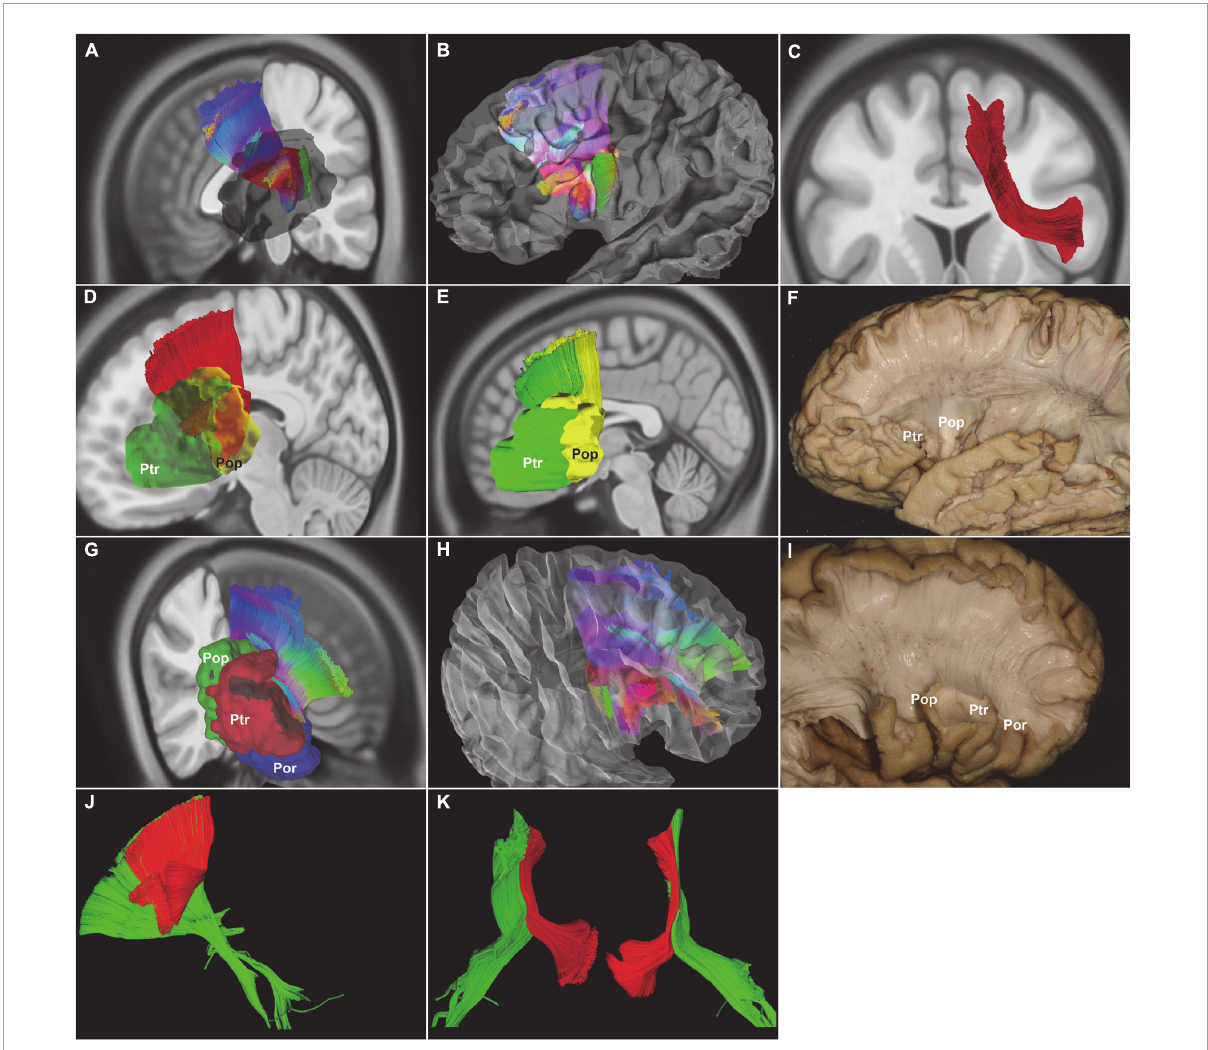
FIGURE4 In vivo fiber tractography of the FAT (HCP-842). (A–C,F) The left FAT arose from the Broca’s region and projected to the SMA, MSFG, and LSFG. (D,E) Further analysis of the fiber contribution between the Ptr (green) and Pop (red). (G–I) The right FAT covered almost the entire length of the IFG. (J,K) The FAT fibers (red) were a very thin layer above the internal and external capsule fibers (green). FAT, frontal aslant tract; IFG, inferior frontal gyrus; LSFG, lateral superior frontal gyrus; MSFG, medial superior frontal gyrus; SMA, supplementary motor area; Pop, pars opercularis; Ptr, pars triangularis; shadow area, Broca’s region.